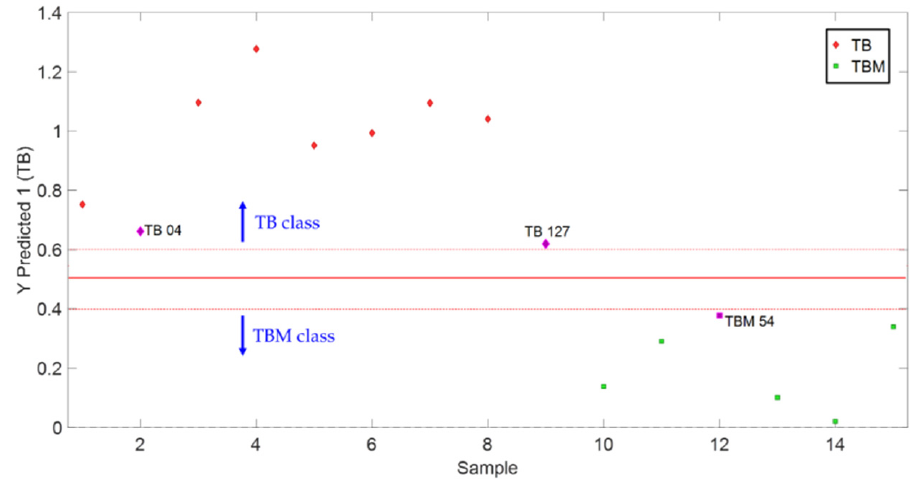
Figure 6. Classification plot for PLS-discriminant analysis (DA) validation results. The solid red line represents the threshold decision value (0.5) and the dotted red lines the uncertainty region. The contingency results for validation are shown in Table 3, which were employed to obtain the main four QPMs (Table 2). According to these results, it becomes clear that the PLS-DA model is able to correctly classify new samples in the corresponding class with 100% confidence. Table 3. Classification of the validation samples using